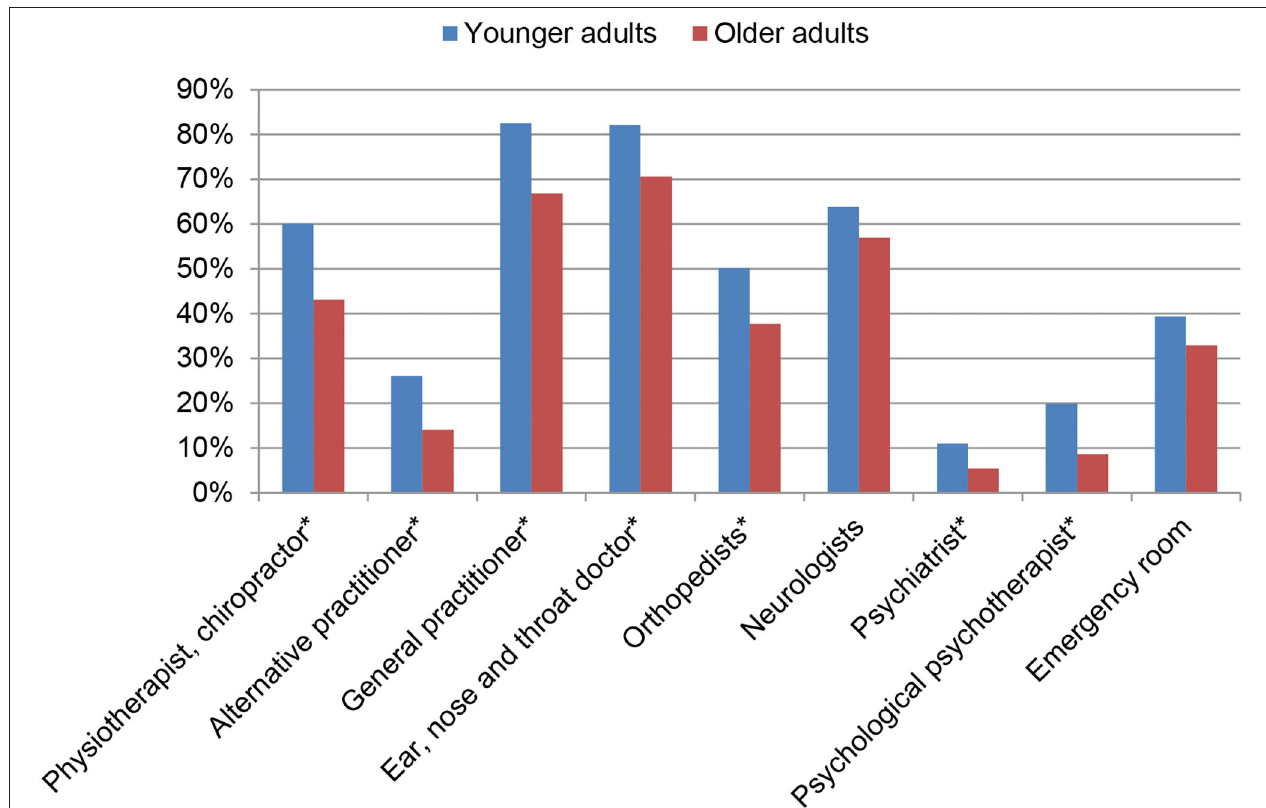
FIGURE 2 | Utilization of medical assistance for dizziness in younger and older adults. * indicates significant group difference at P < 0.001.